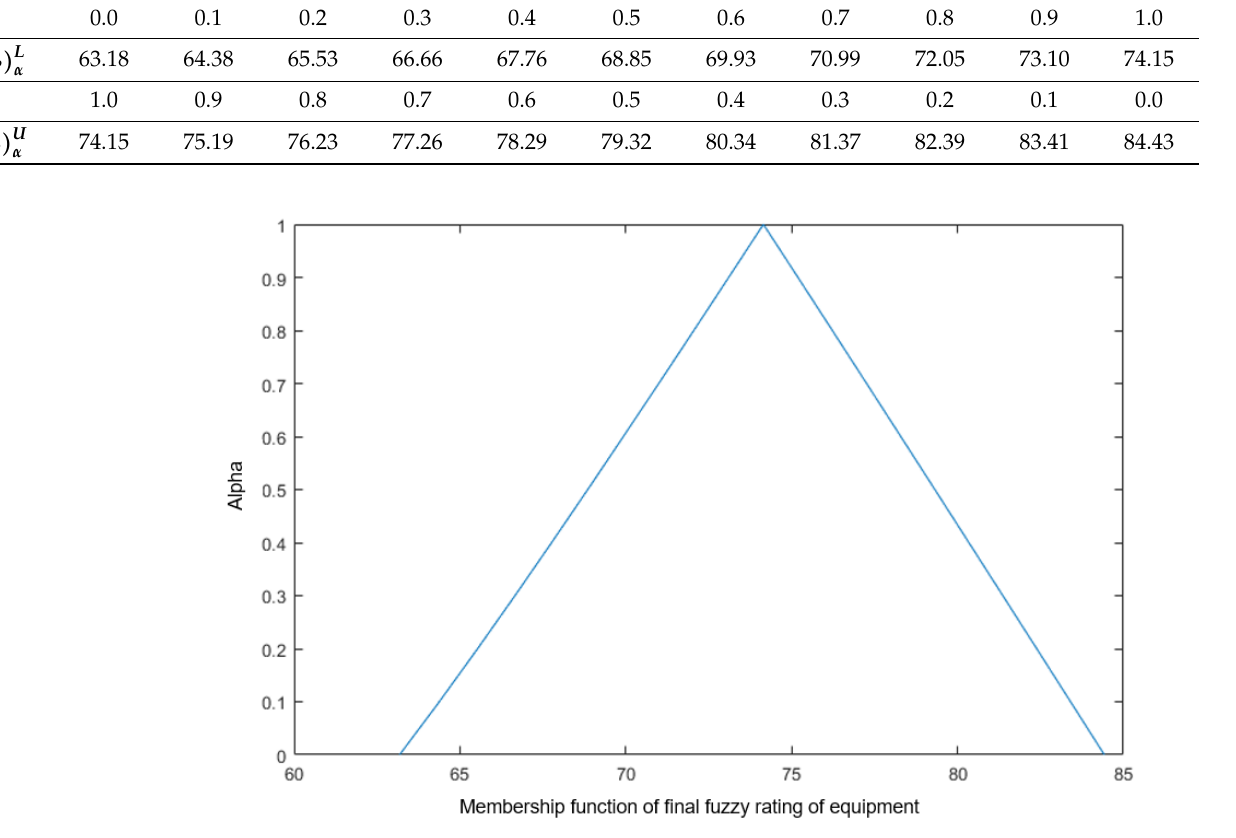
Figure 11. Graphical representation of the membership function of equipment component final rating for all combinations.